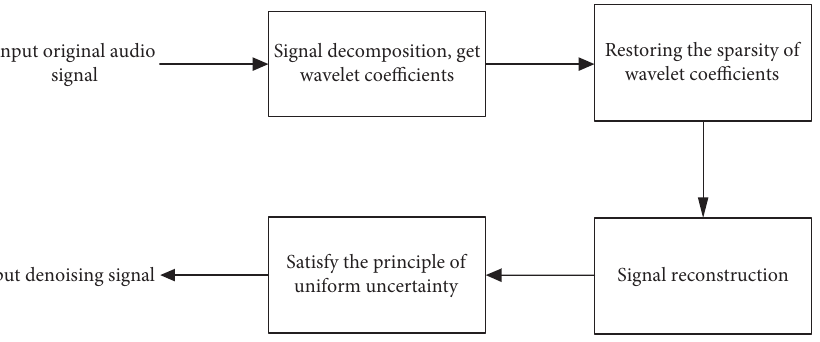
Figure 1: Music denoising process.